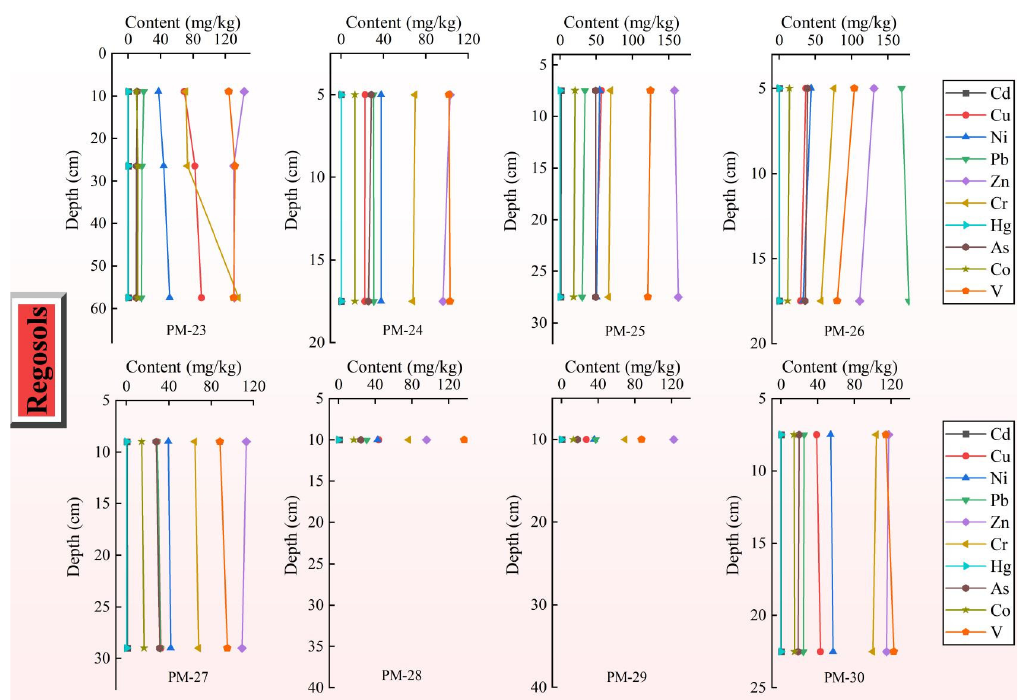
Figure 5. Distributions of HMs (Cd, Hg, Cu, Ni, Pb, Zn, Cr, As, Co, and V) in the Regosols profile ( N = 8).